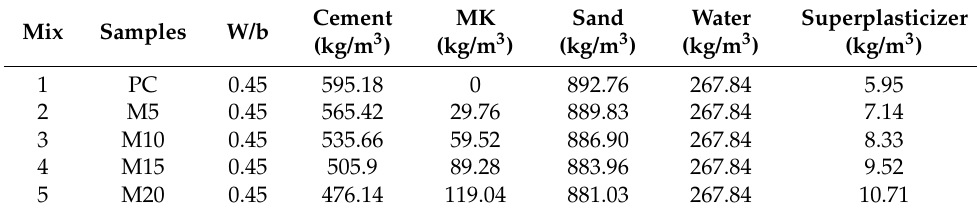
Table 3. Proportions of mortar mixture.